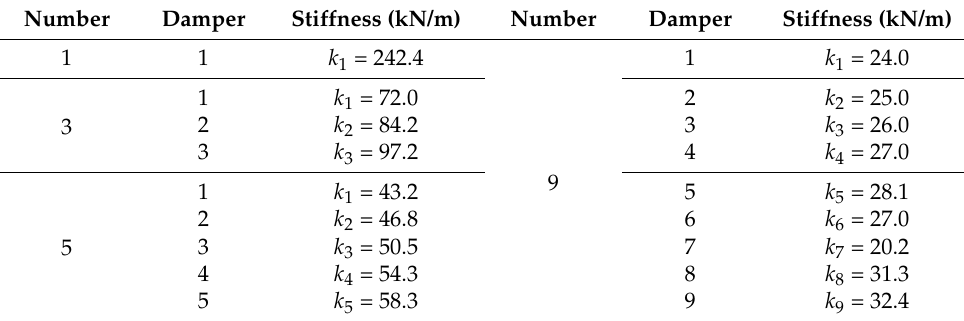
Table 11. Design parameters of MTMD under different damper